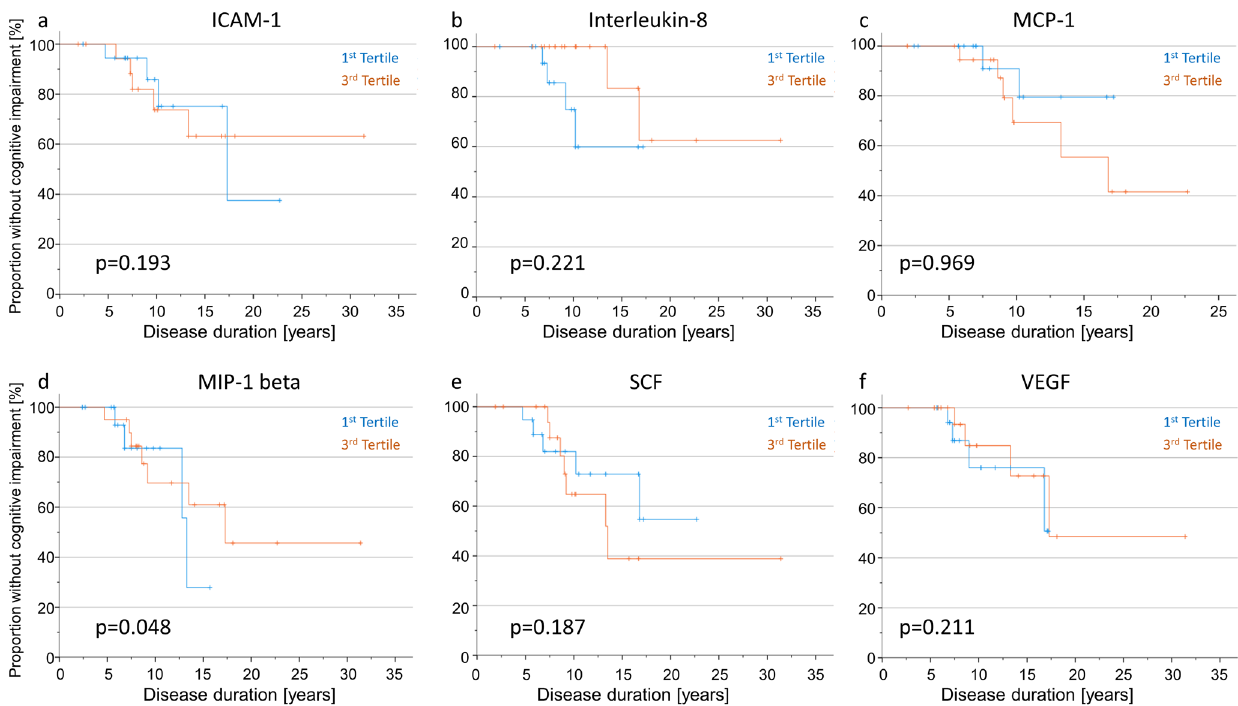
Fig. 2 Kaplan – Meier curves and Cox regression analyses depicting the duration until the development of cognitive impairment in PD GBA people strati fi ed by in fl ammatory pro fi les. a – f Kaplan – Meier analyses of the most relevant in fl ammatory markers (ICAM-1, interleukin-8, MCP-1, MIP-1 beta, SCF and VEGF) revealed no signi fi cant impact on the duration until the development of cognitive impairment. However, adjusting the model for age, sex and disease duration as additional interacting co-variates MIP-1-beta showed a signi fi cant effect on the duration until the development of cognitive impairment in Cox regression analyses. Fifty percent of patients with high CSF levels of MIP-1- beta at baseline (third tertile) reached this clinical endpoint after 17 years compared to 13 years in patients with low levels ( fi rst